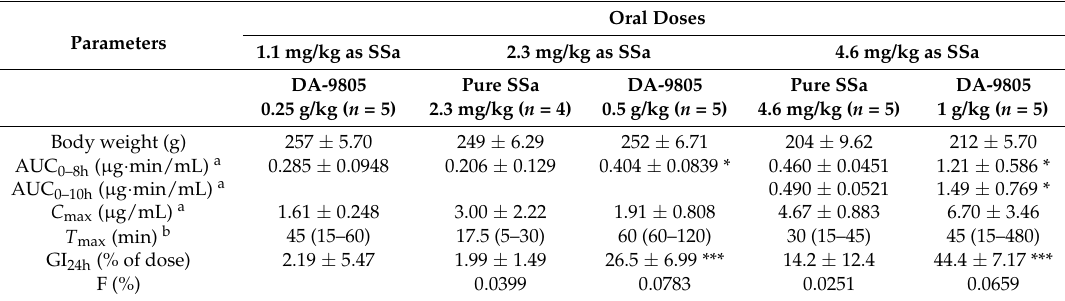
Table 2. Pharmacokinetic parameters of SSa after oral administration of pure SSa or DA-9805 at doses equivalent to 1.1, 2.3, and 4.6 mg/kg of SSa to rats (mean ± SD).